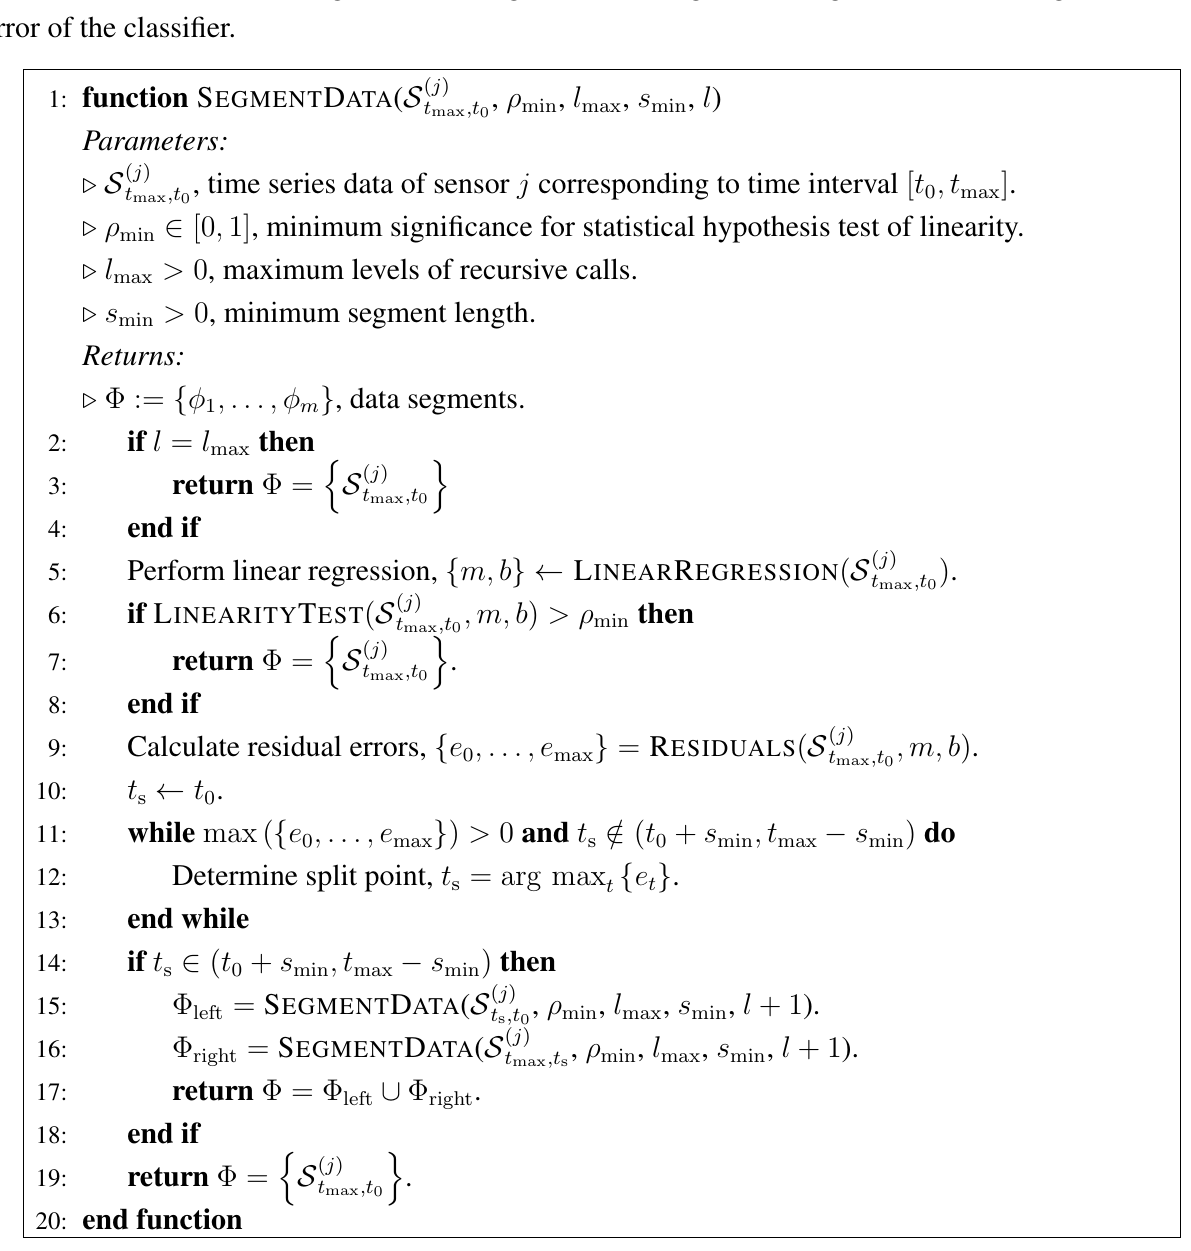
Figure 2. Pseudocode of yet another segmentation algorithm